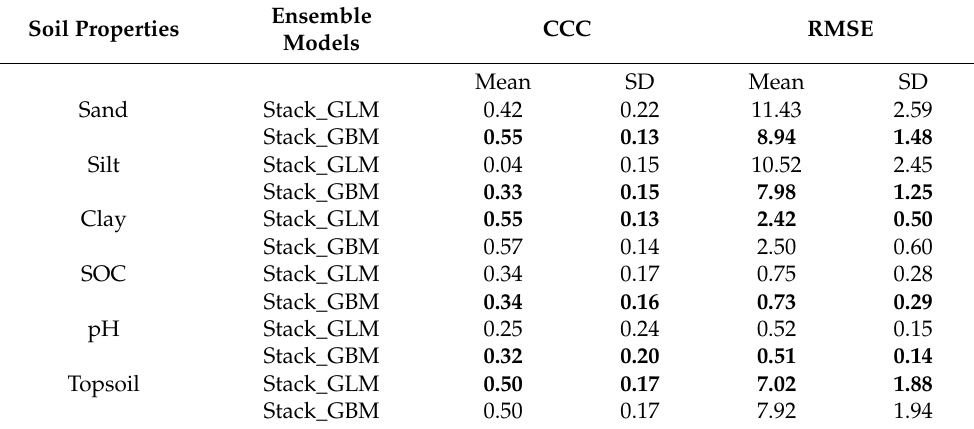
Table 5. Ensemble model performance based on repeated ten-fold